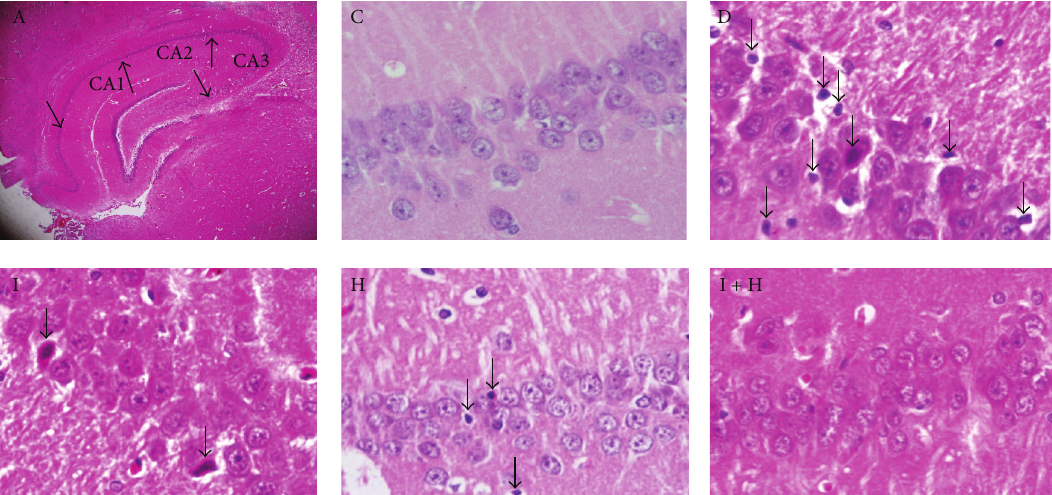
Figure 1: The effects of insulin and honey on neural cell death of hippocampus. Neuronal cell death was evaluated via hematoxylin-eosin staining at 400x magnification (arrows show the dead neuronal cells). A: different parts of hippocampus; C: the control group; D: untreated diabetic group; I: diabetic rats treated with insulin; H: diabetic rats treated with honey; I + H: diabetic rats treated with insulin and honey simultaneously.